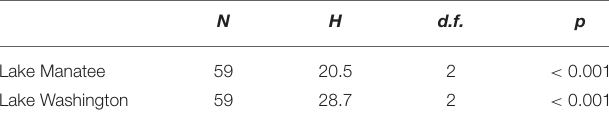
TABLE 2 | Summary of independent-samples kruskal-wallis H tests. N H